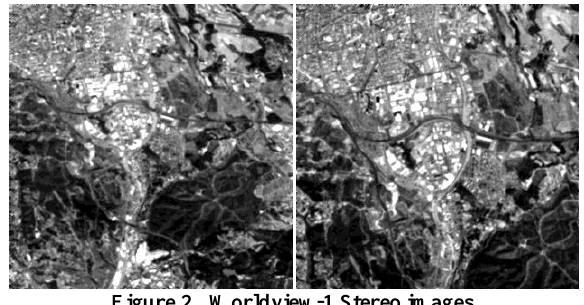
Figure 2. Worldview-1 Stereo images